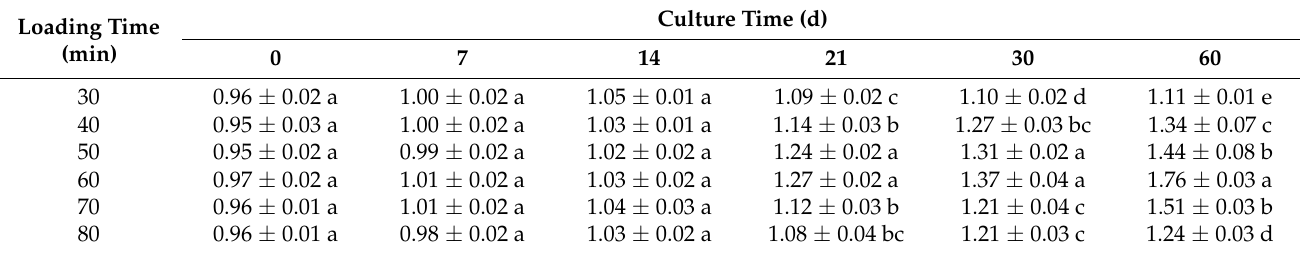
Table 3. Effect of loading time on fresh weight of F. mandshurica EC after vitrification cryopreserva- tion.